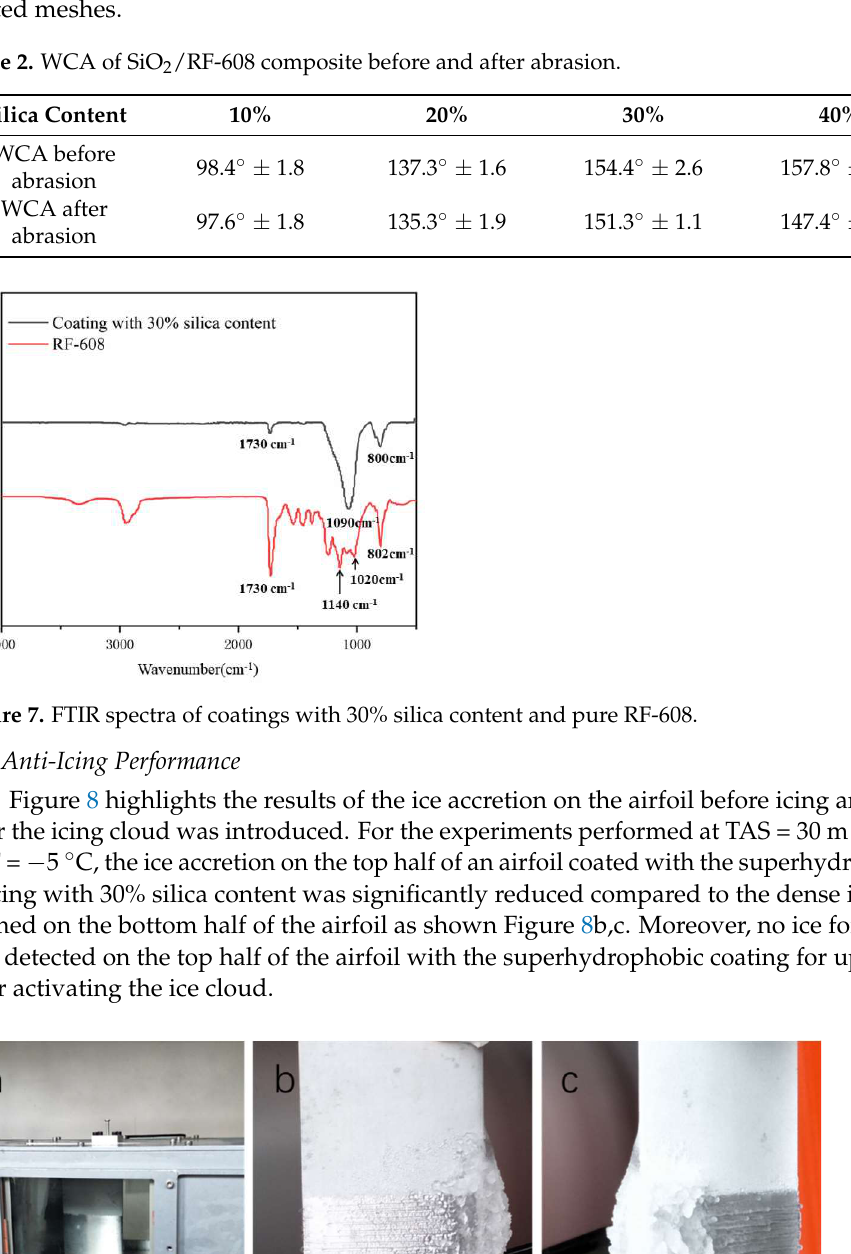
Figure 8. Top view before the experiments ( a ). Ice accretion on an airfoil with different angles ( b , c ).